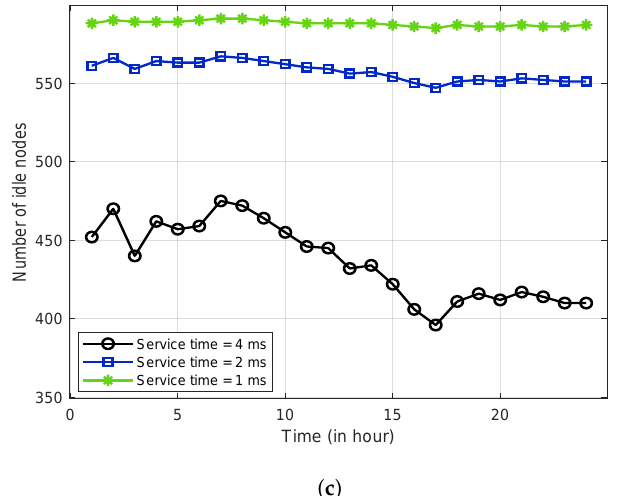
Figure 7. The influence of service time of a fog node on the number of selected WFNs, SFNs and IFNs in GDAFC. ( a ) The number of WFNs; ( b ) the number of SFNs; ( c ) the number of